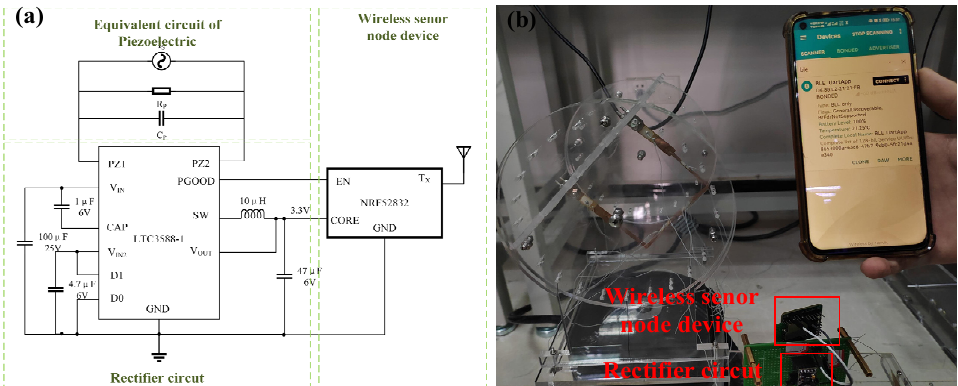
Figure 15. Applying proposed PVEH in powering a wireless sensor node. ( a ) Circuit diagram of the